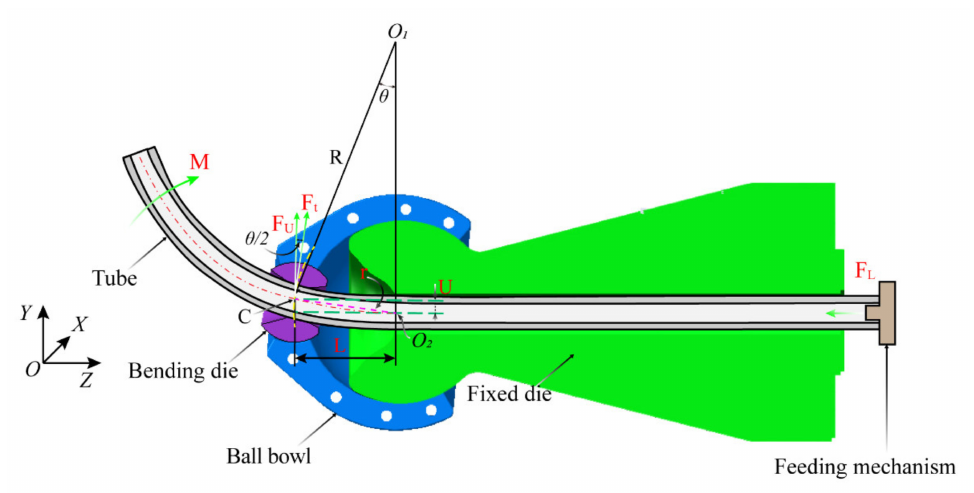
Figure 2. Schematic diagram of free bending forming